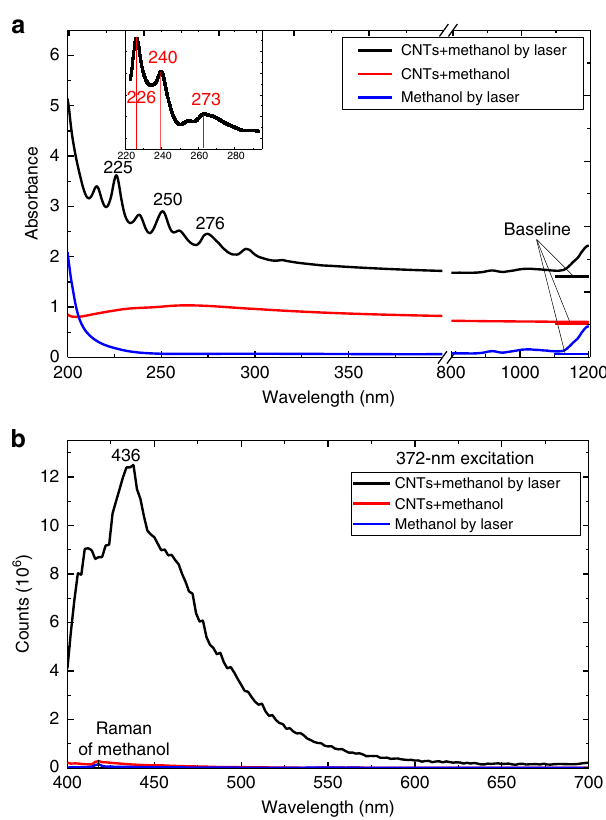
Fig. 4 Optical absorption and photoluminescence spectra. Spectra of crude T-carbon products ( black ) compared to pristine carbon nanotube suspension ( red ) and methanol irradiation products ( blue ). a UV – Vis absorption (absorption lines were vertically shifted) ( inset shows the simulated absorption curve). b Photoluminescence